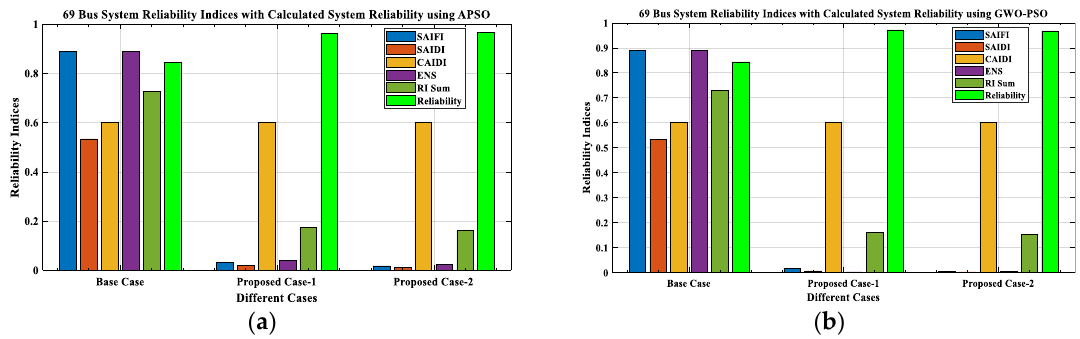
Figure 26. Reliability indices with system reliability of the 69-bus RDN; ( a ) APSO, ( b ) GWO-PSO.